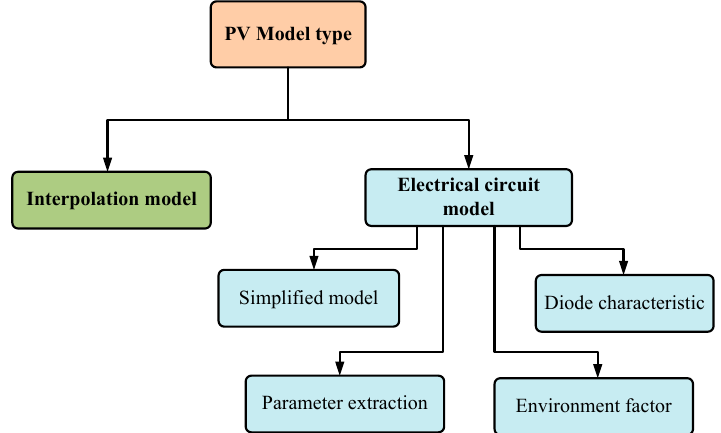
Figure 2. Description of the PV model type considered in PV emulator applications.